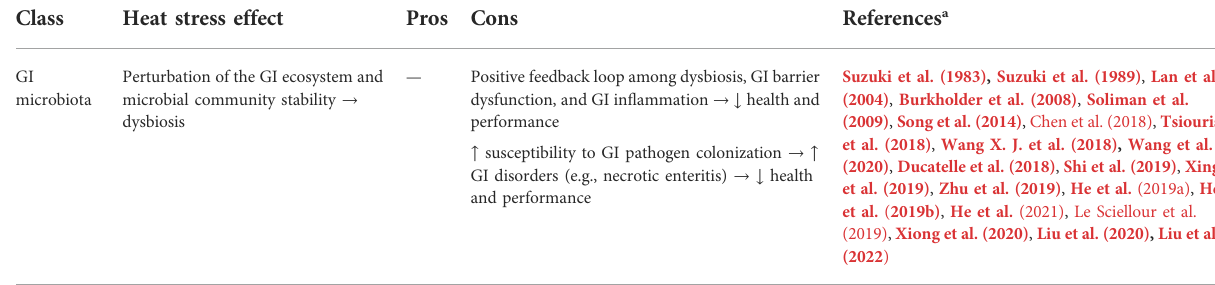
Upward arrow ( ↑ ), increase; downward arrow ( ↓ ), decrease; rightward arrow ( → ), consequence/degeneration. a Include studies on non-avian species that have exhibited comparable heat stress effects and responses to those observed in chickens. Studies with the focus on chickens or poultry are highlighted in